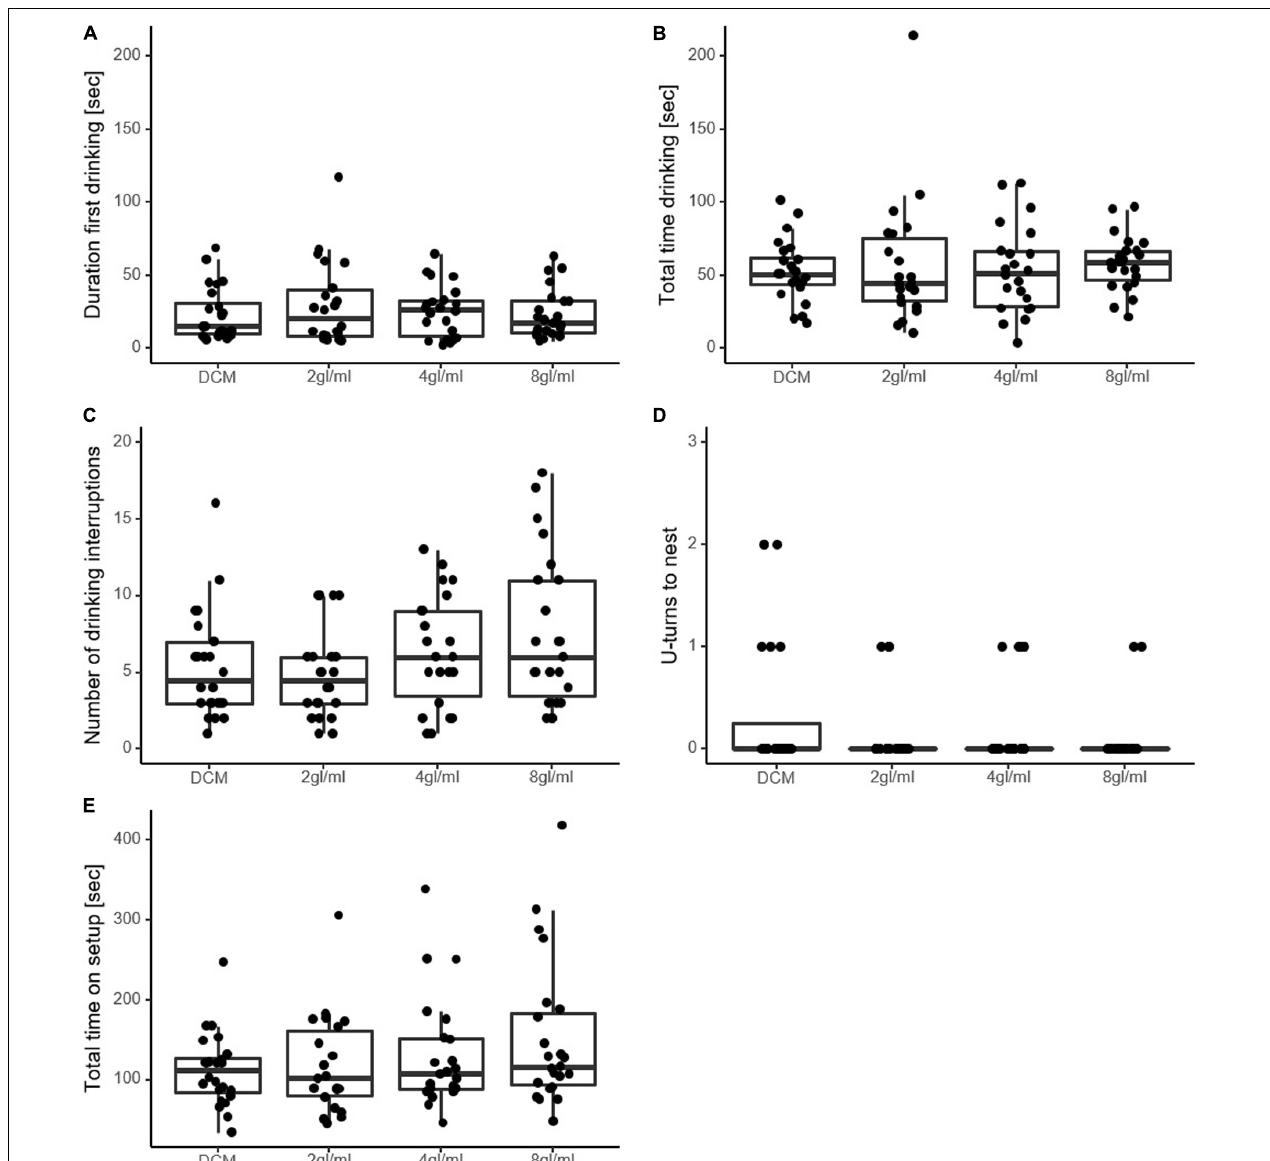
FIGURE 2 | Measures of perceived food value in experiment 1. (A) Seconds ants spent drinking until they first moved away from the sucrose drop. (B) Seconds spent drinking in total. (C) Number of drinking interruptions over the course of the trial. (D) Number of U-turns made by the ant on the way back to the nest. Was only counted when ants moved at least 2 cm in an opposite direction. The majority of ants did not perform U-turns. (E) Seconds the ants spent on the setup in total. Note that none of the variables differed significantly between the solutions, except in (C) , where 8 gl/ml is significantly higher than DCM. DCM, dichloromethane solvent; Xgl/ml, x pheromone glands per milliliter